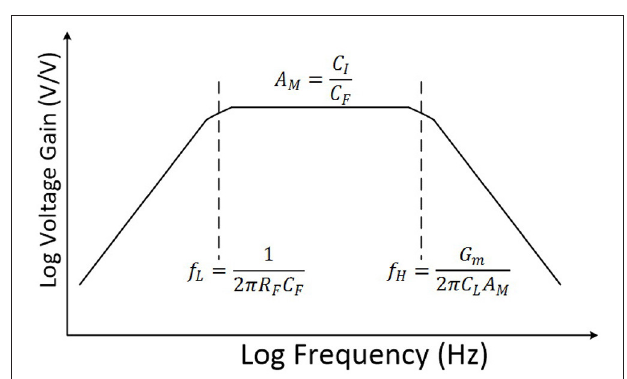
FIGURE 2 | Frequency response of the